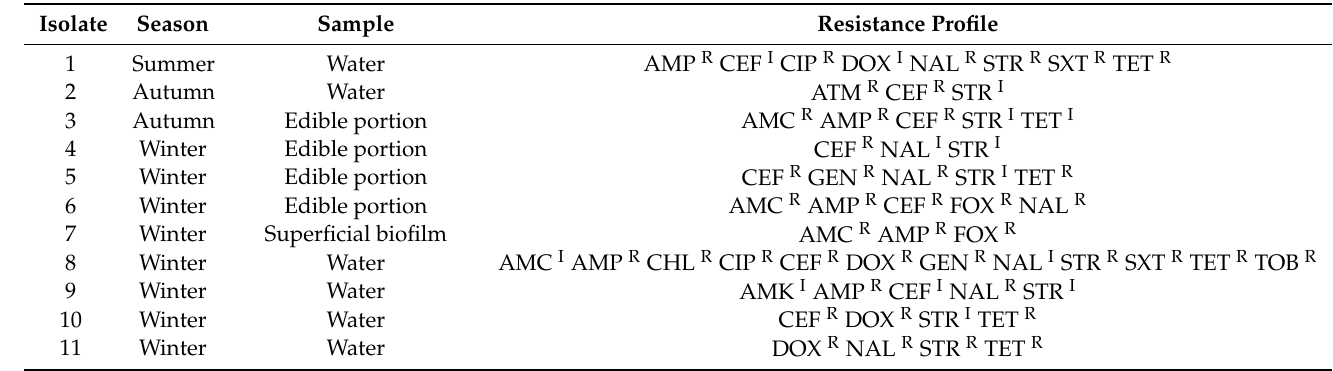
Table 4. Resistance patterns in E. coli MDR strains isolated from the farming waters, edible portions, and superficial biofilm samples.